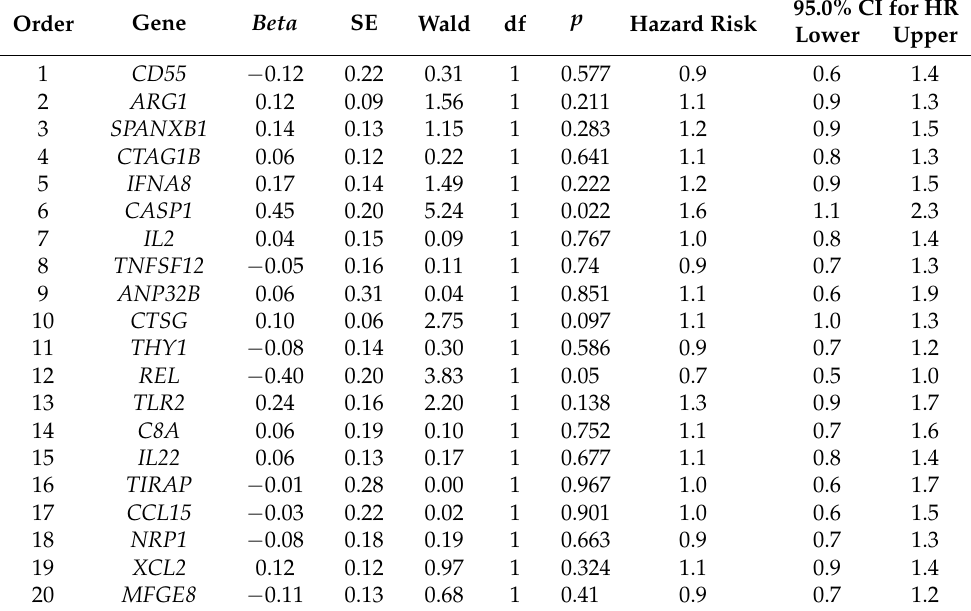
Table A1. Correlations between the top 20 genes of the multilayer perceptron and the overall survival of the patients (univariate analysis).